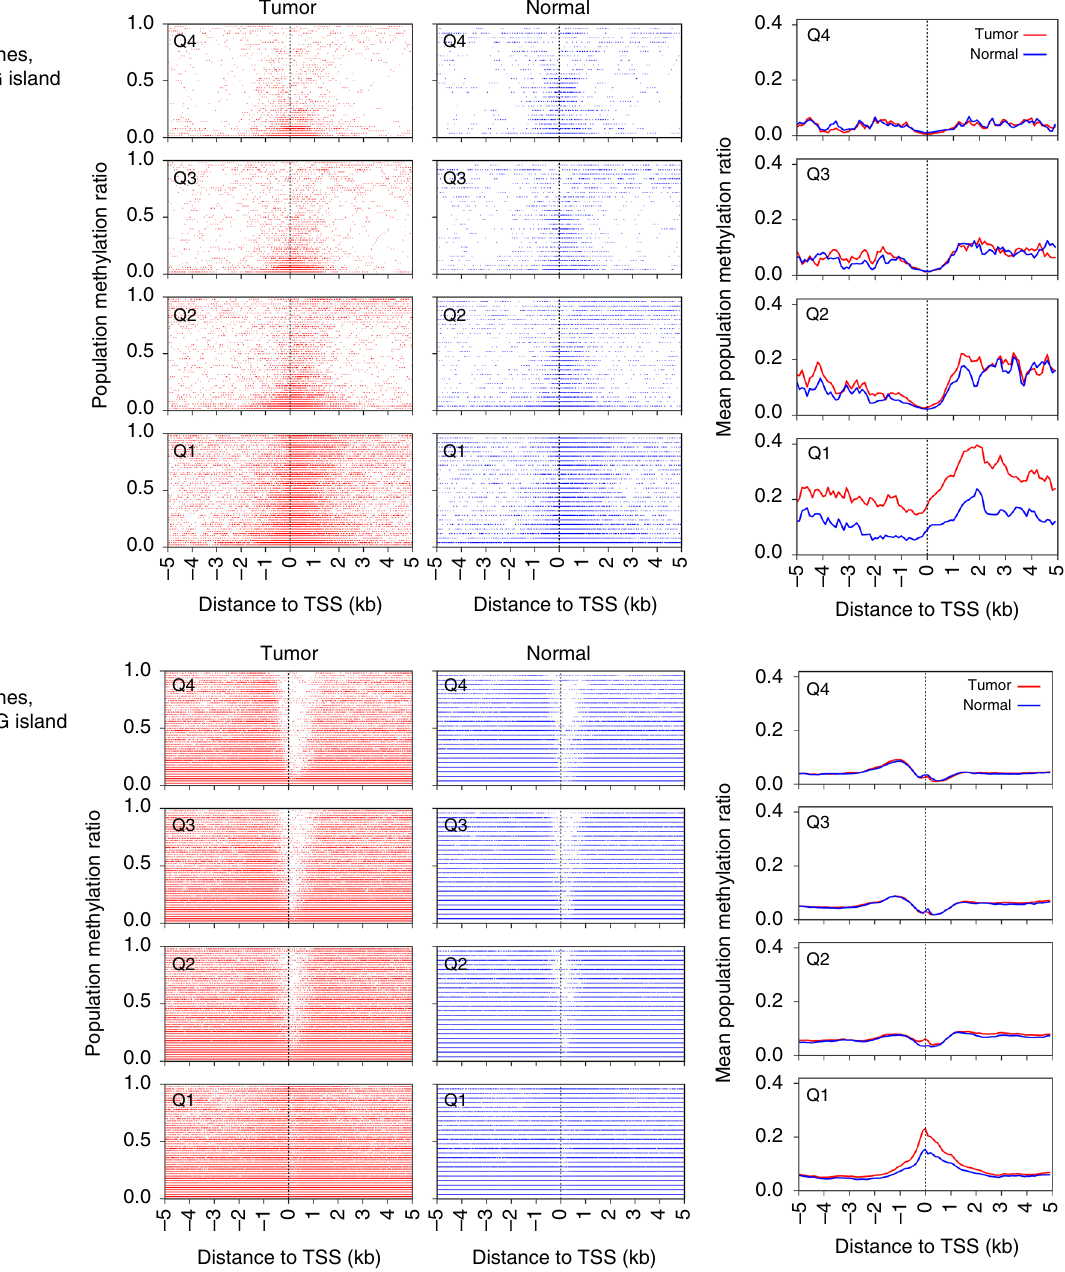
Fig. 1 DNA methylation and gene expression in HPVOPSCC and normal oropharynx. Scatter plots (left panels) separated by gene expression quartiles based on the expression levels in either tumor or normal samples ( n = 3290, 3289, 3289, 3290 for Q1, Q2, Q3, Q4, respectively; Q4 is the highest expression) showing methylation ratio at 100 bp segments including genomic loci within ( a ) and outside ( b ) CpG islands in genes with promoter- associated CpG islands (CGI genes, n = 13158). CGI genes have the CpG island-containing promoter by de fi nition, though they may have additional CpG island(s) outside of the promoter region. a Shows methylation status at each 100 bp segment with such CpG island. As CGI genes also have various methylation pro fi les at CpG sites outside of the island(s), i.e. shore(s) etc., such 100 bp segments are plotted in b . Thus non-overlapping 100 bp segments of an identical set of CGI genes are shown in a , b . Right panels show the mean values. TSS transcription start